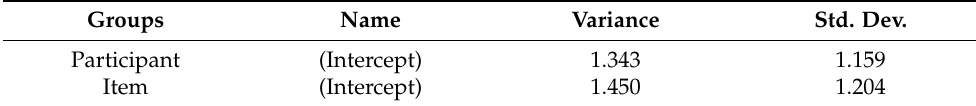
Table A9. English T1 random effects.